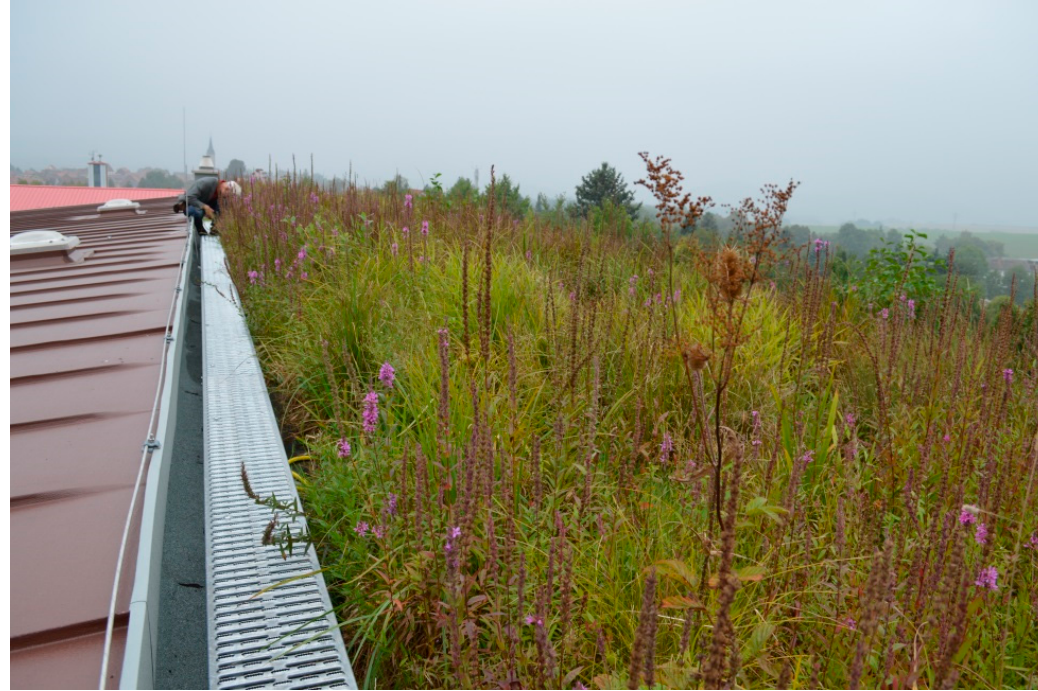
Figure 4. Building with half the roof area covered by a wetland roof (photo: Michael Blumberg).